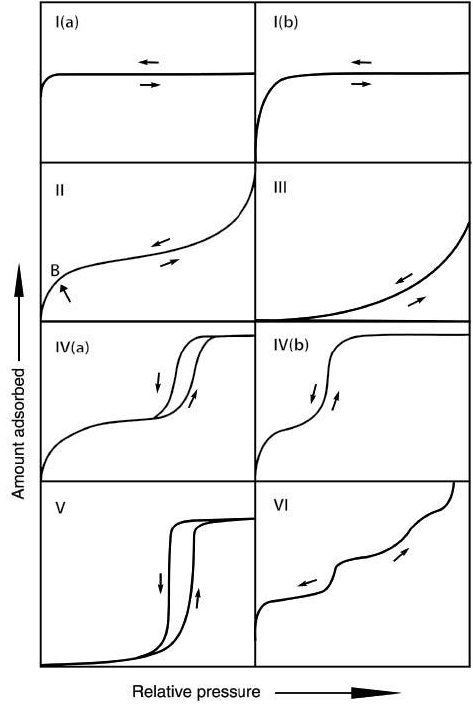
Figure 2. Classification of physisorption isotherms according to [9].